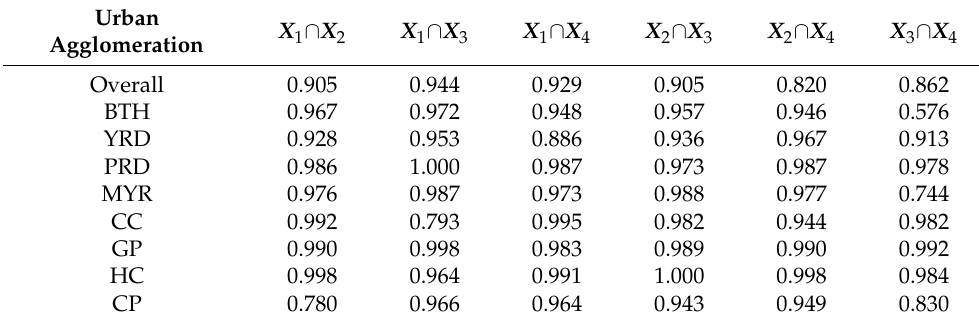
Table 7. Explanatory power of four-dimensional interaction